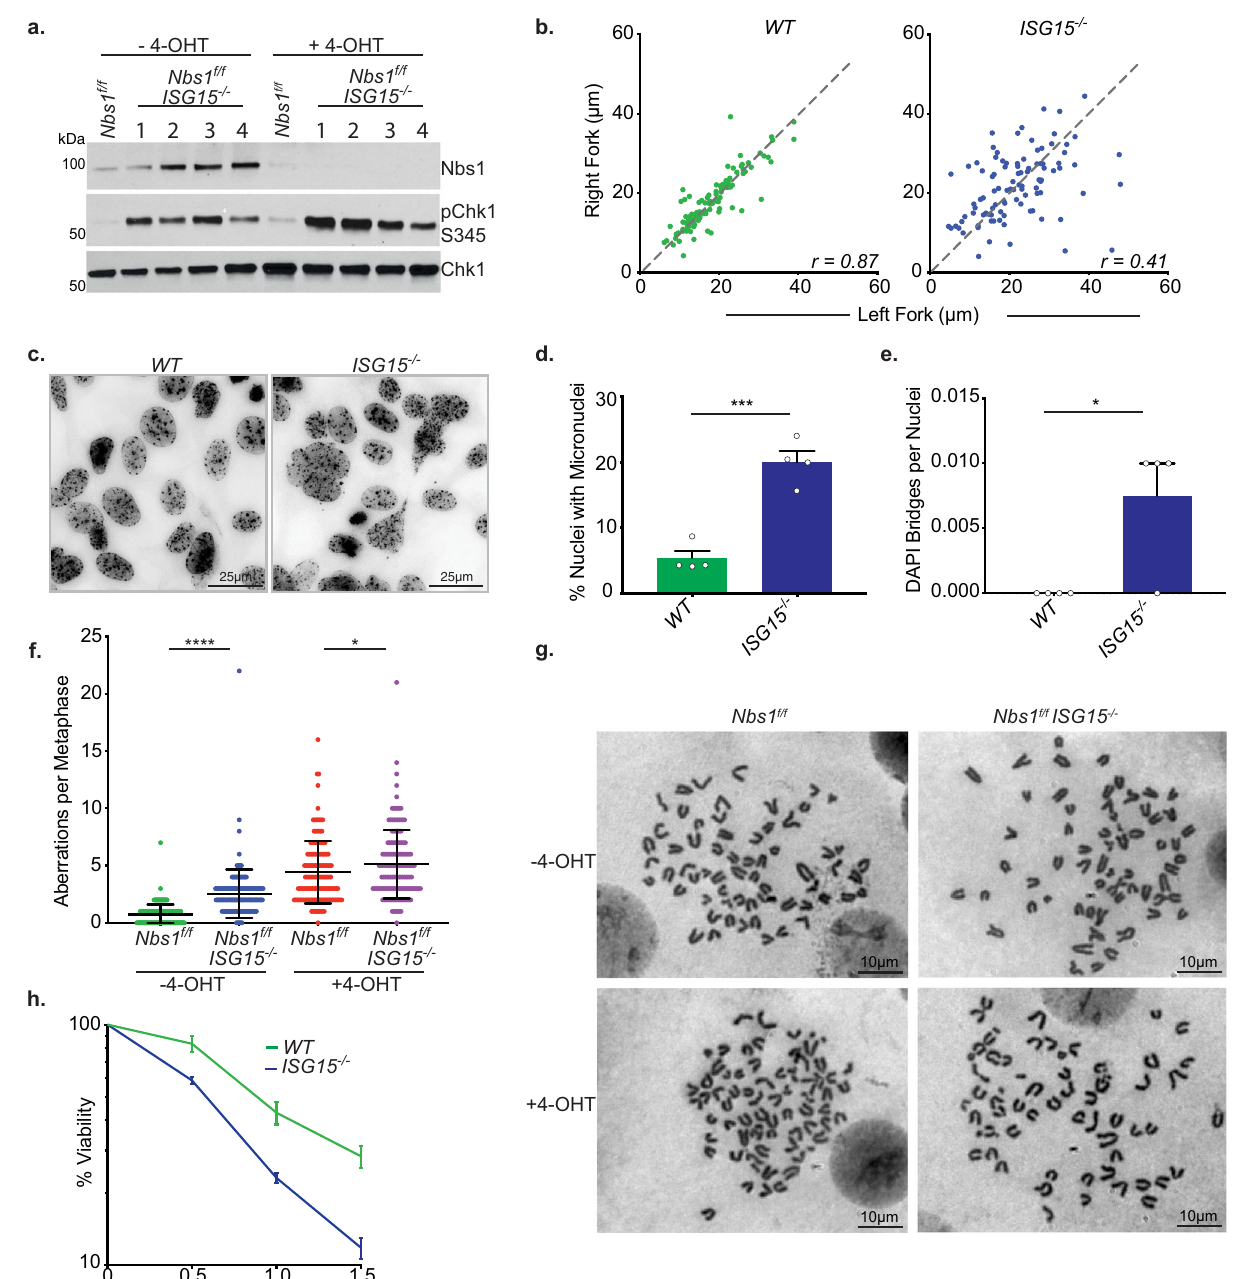
e Quanti fi cation of DAPI stained DNA bridges in the indicated cell lines. Mean of four independent experiments with SEM. Two tailed unpaired t -test, * = p 0.0240. f Quanti fi cation of metaphase spreads with or without induction of Nbs1 deletion. Combined data from three independent experiments. Between 45 and 52 meta- phases were counted per condition per biological repeat ( Nbs1 f/f − 4OHT n =152; Nbs1 f/f ISG15 − / − − 4-OHT n =148; Nbs1 f/f +4-OHT n =144; Nbs1 f/f ISG15 − / − +4-OHT n =146).Meanwith SD shown.Two-tailed Mann – Whitney test ****= p <0.0001,*= p 0.0207. g Example images for data shown in f. h Viability ten days after 16h aphi- dicolin (Aph) treatment as seen via colony forming assay. Mean of three indepen- dent experiments with SEM. Source data are provided with this